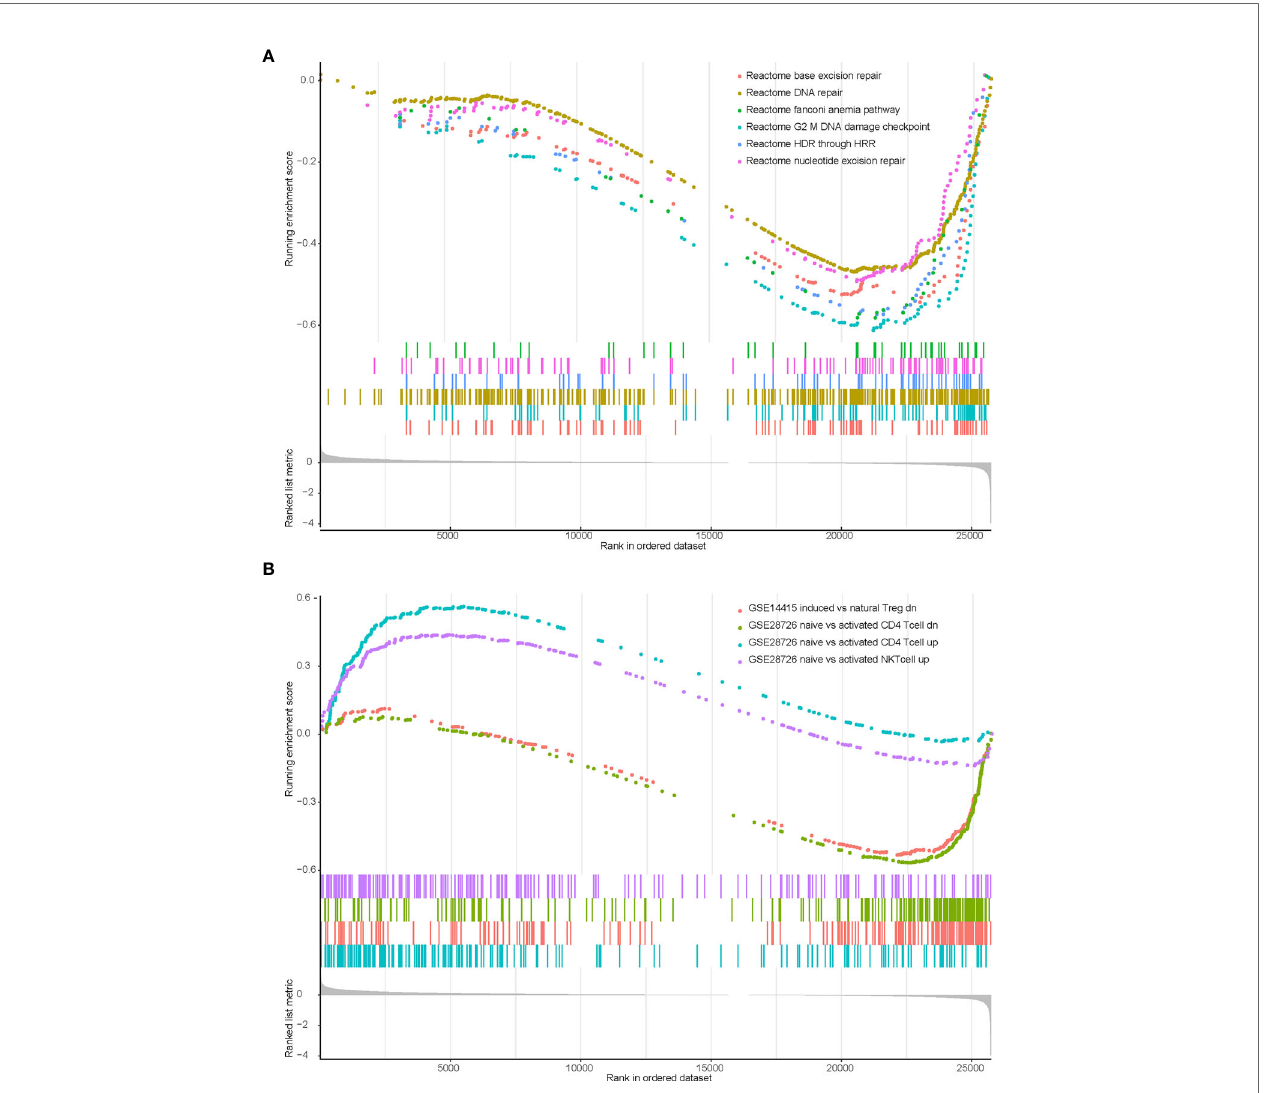
FIGURE 5 | Enrichmentplotshowingbiologicalsignaturesbasedongeneset enrichmentanalysis(GSEA) ofKEAP1/NFE2L2mutantNSCLC. (A) :Signi fi cantdown-regulationin multiple DDR-relatedpathwaysincludingbase excisionrepair, DNArepair,fanconianemiapathway, G2M DNA damagecheckpoint, HDR throughHRRandnucleotideexcision repair. (B) : Signi fi cant down-regulationinCD4Tcell(thegreenandbluecurves)andNKTcell(thepurplecurve),signi fi